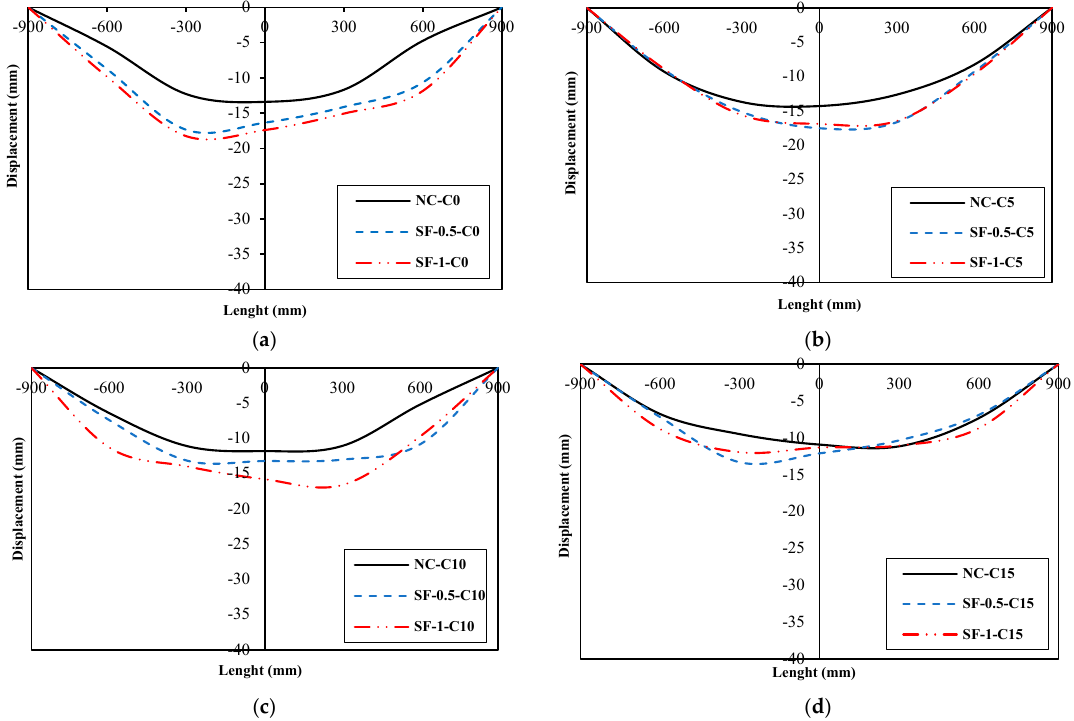
Figure 15. Displacement longitudinal profile diagrams: ( a ) Group A specimens ( b ) Group B specimens ( c ) Group C specimens ( d ) Group D specimens. Displacement longitudinal profile diagrams of all beams are asymmetric, and the value of displacement in the half of the failing beam is greater than in the other half.